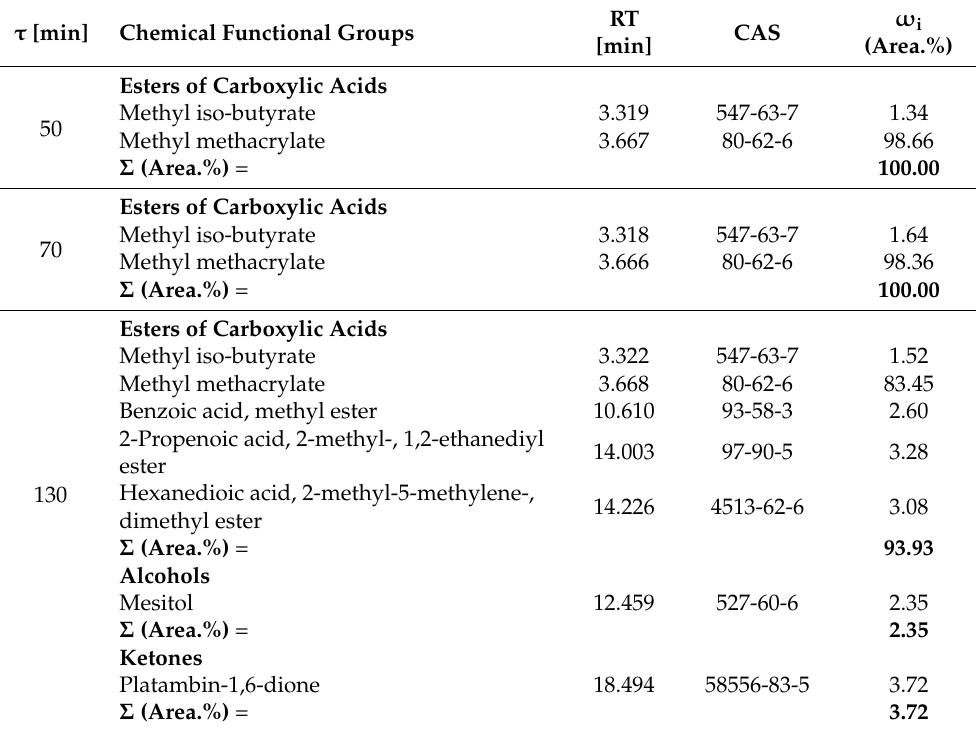
Table 7. Functional groups, sum of peak areas, chemistry registry numbers (CAS), and retention times of molecules identified by gas chromatography-mass spectrometry (GC-MS) in the liquid phase by depolymerization of PMMA based dental resins fragments/residues at 405 ◦ C, atmospheric pressure, and time interval of 50 to 130